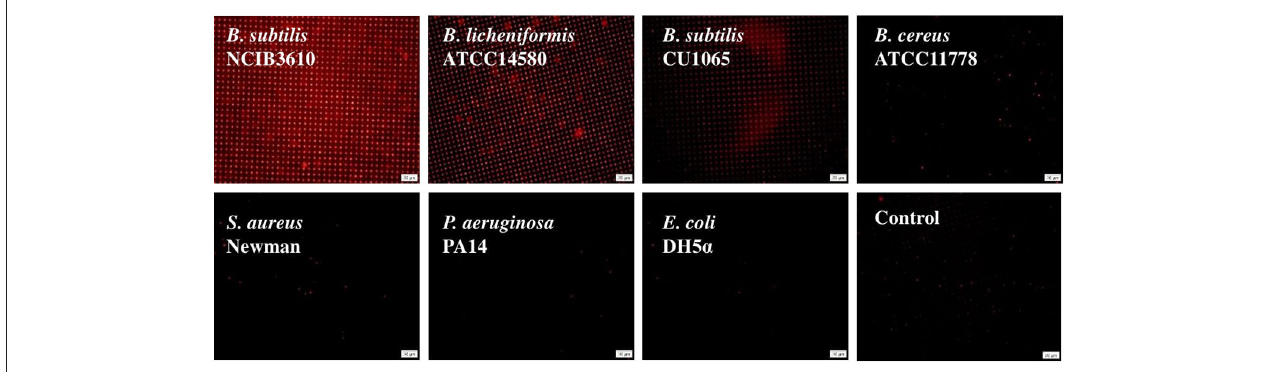
FIGURE 8 | Fluorescence images of sensor platform after exposed to the media supernatant of different bacterial strains which were grown in LB for 24h.